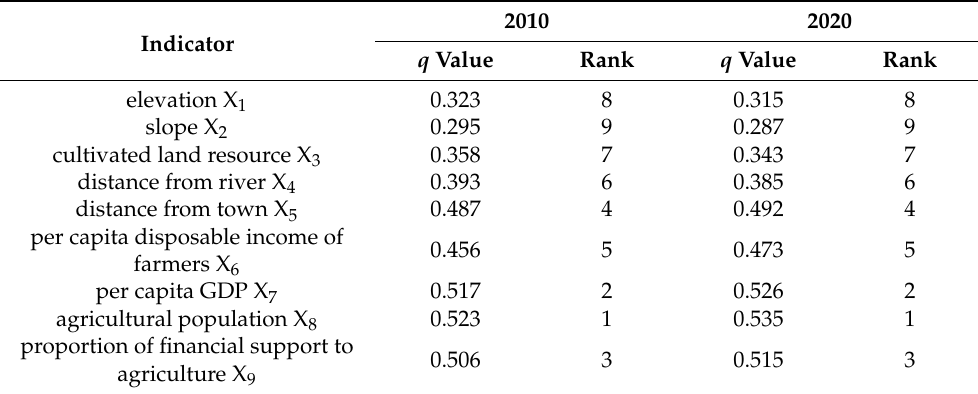
Table 5. Detection results of factors influencing the distribution of rural settlements. Indicator